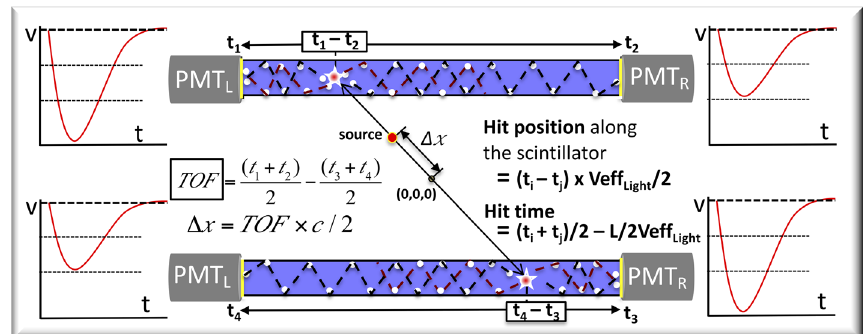
Fig. 3 Demonstrates the principle of the J‑PET scanner based on two plastic strips. Analog signals measured at four PMTs are also shown. For a scintillator of length L and considering the effective velocity of the light photons inside the scintillator ( Veff Light ), the formula for calculating the hit position and hit time is shown in the figure. The annihilation point can be reconstructed from the measured TOF information between two hit positions (in different/opposite